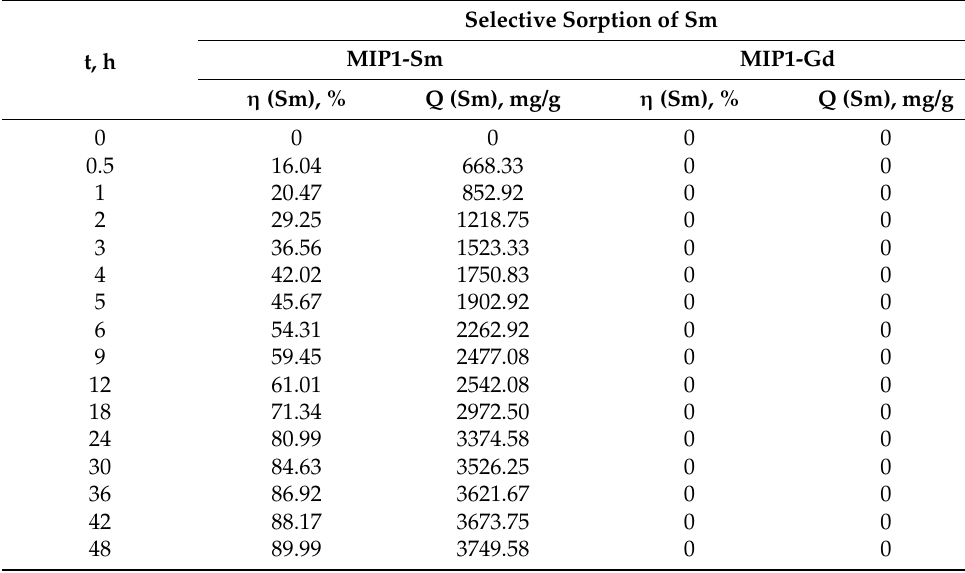
Figure 8. Sorption efficiency of imprinted structures MIP1 and MIP2 in dependence from amount of template removal cycles. Table 8. Sorption properties of the MIP1-Sm and MIP1-Gd structures during selective sorption of